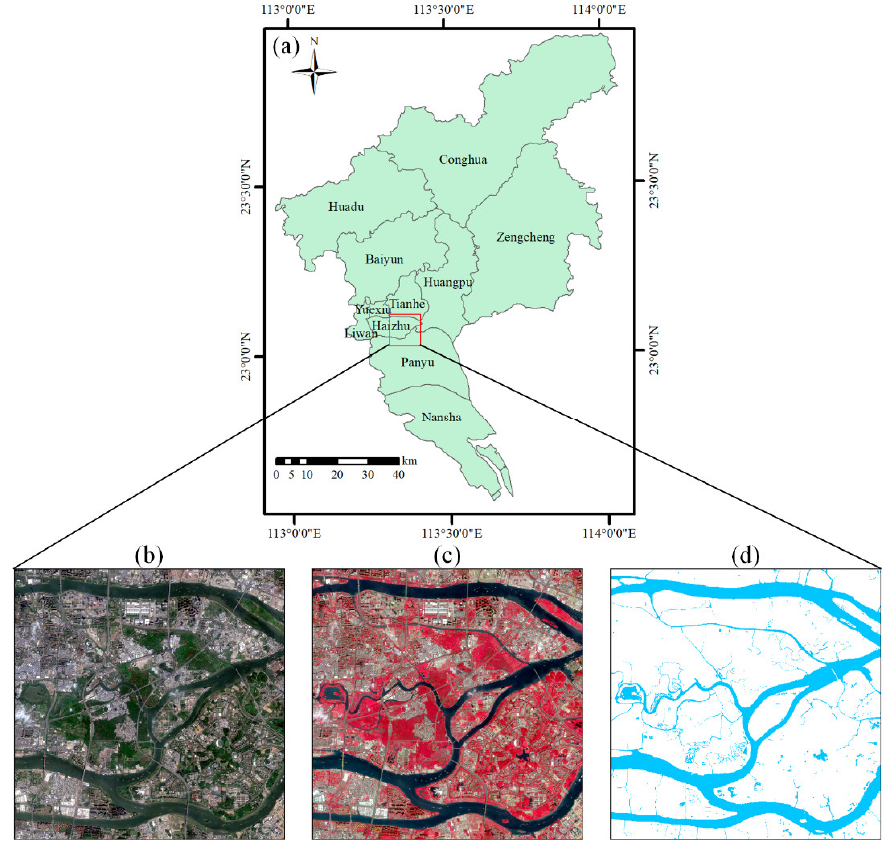
Figure 1. Study area: ( a ) location in Guangzhou city; ( b ) true color image; ( c ) false color image; ( d ) real water body distribution.